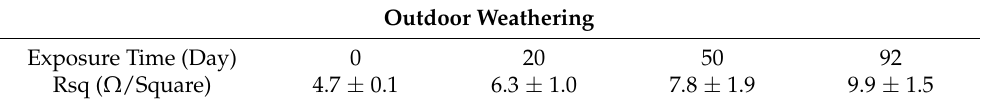
Table 3. Sheet resistance values of OMO samples before and after outdoor weathering